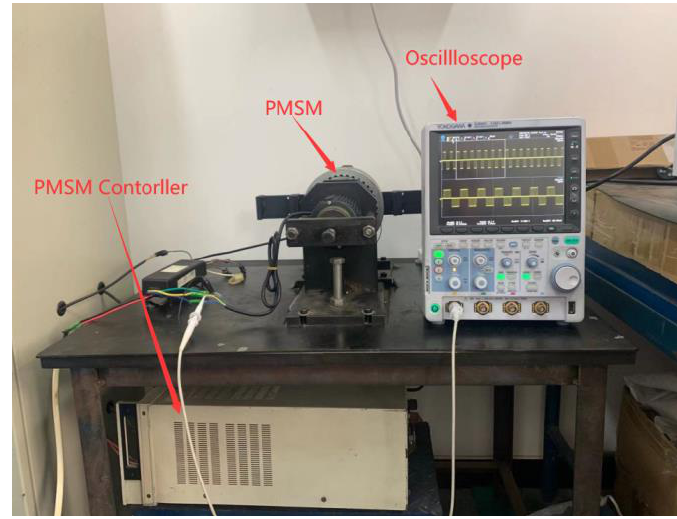
Figure 17. Experimental system platform.